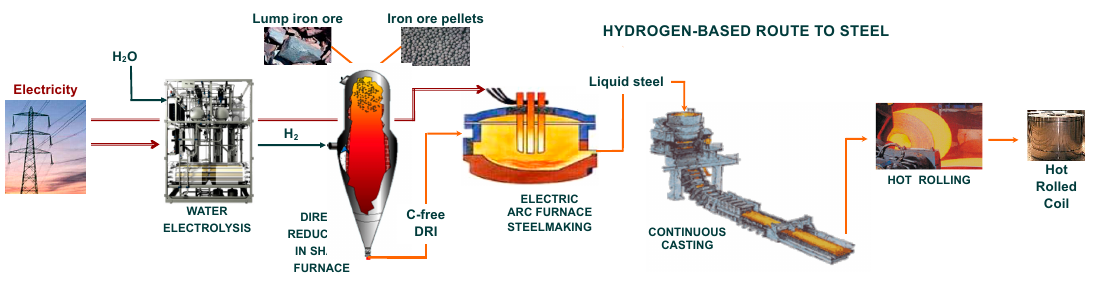
Figure 1. ULCOS hydrogen-based route to steel.